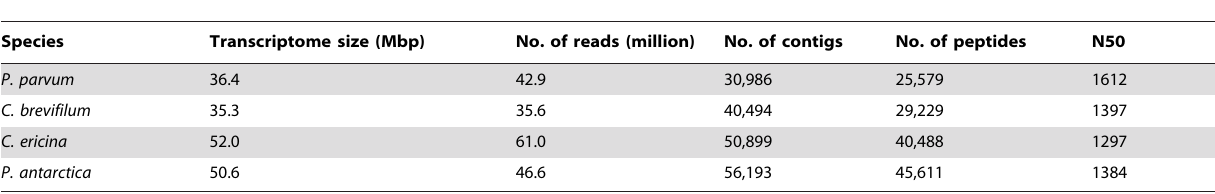
Table 2. Basic statistics for the four transcriptomes sequenced in this study.